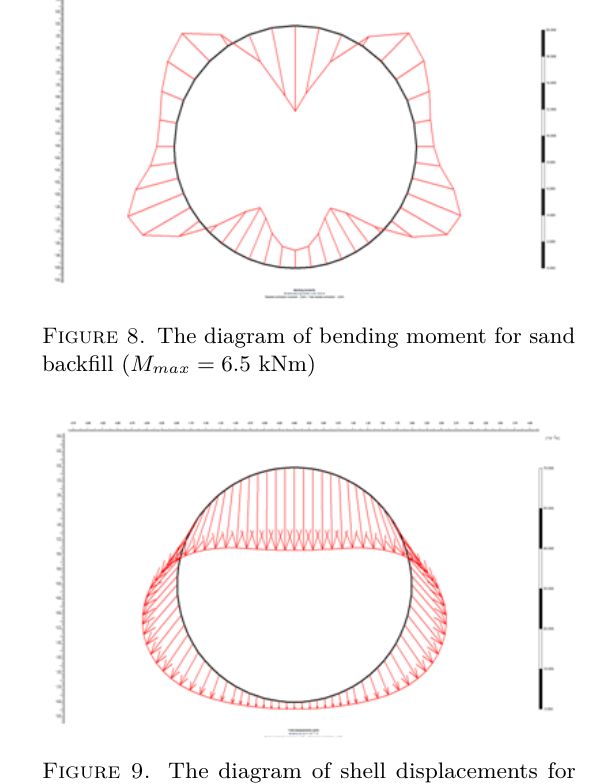
Figure 5. Deformed scheme